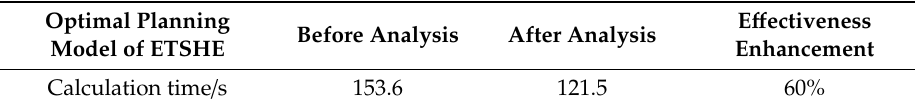
Table 5. Comparison analysis before and after node sensitivity